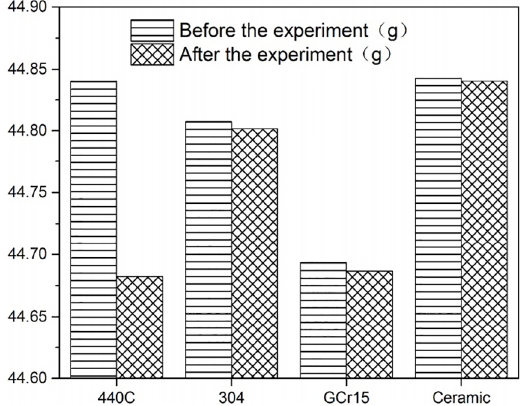
Figure 8. The mass of the 9Cr18Mo sample before and after the tests